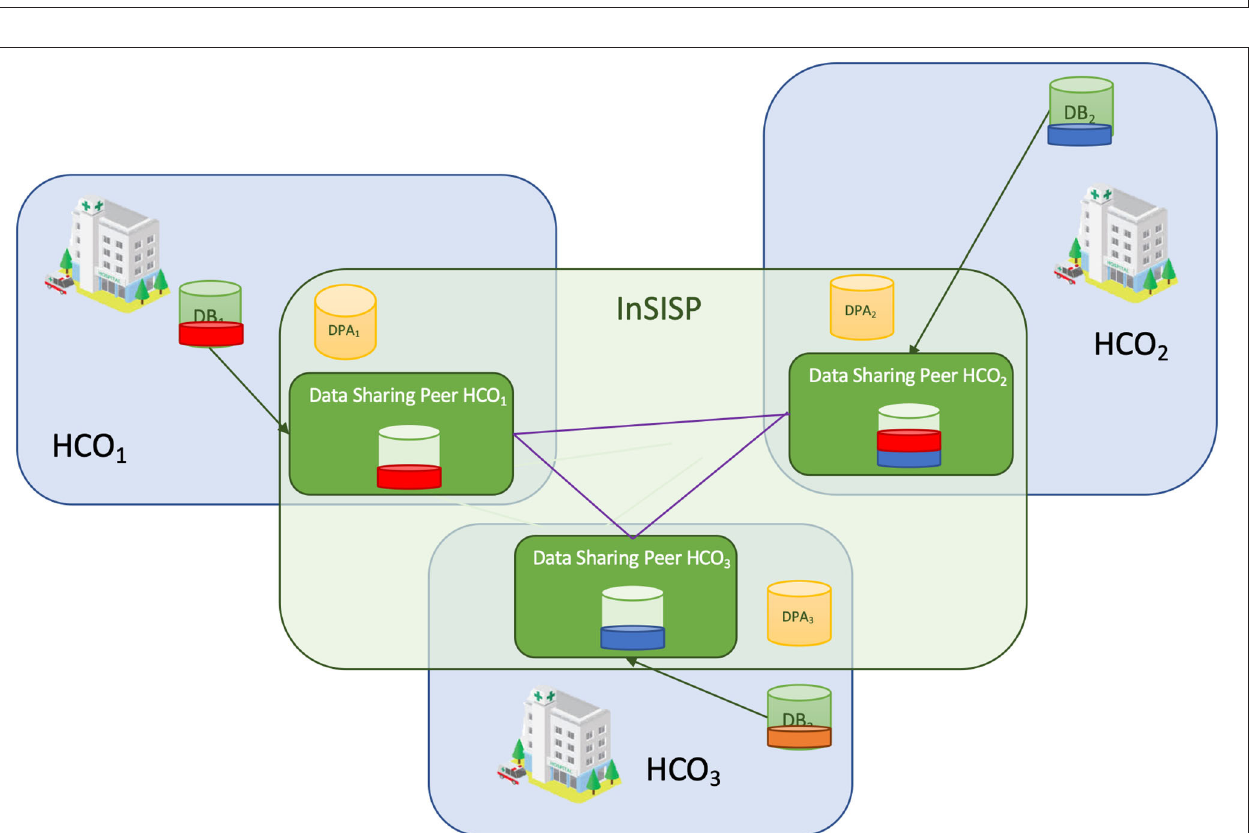
FIGURE 8 | Overview of the peer to peer with shared memory design.